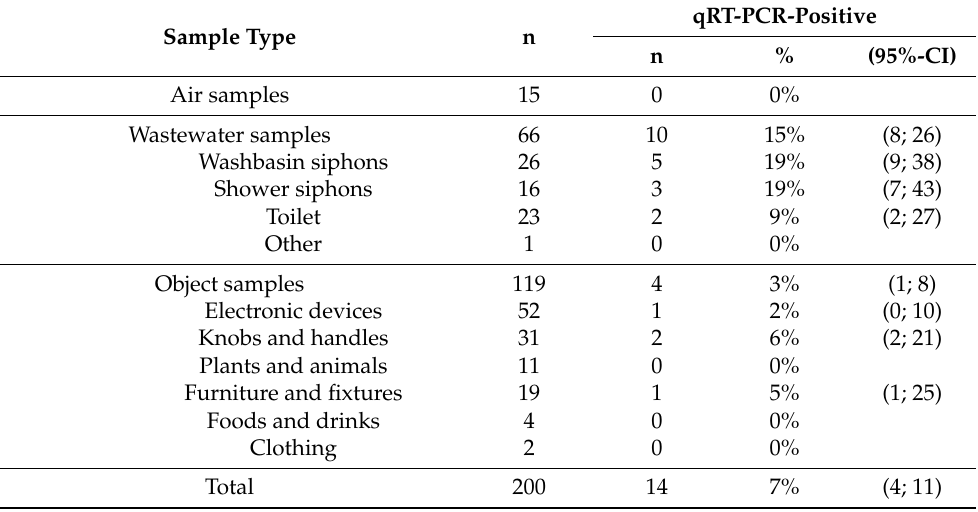
Table 2. Overview of qRT-PCR-positive sample